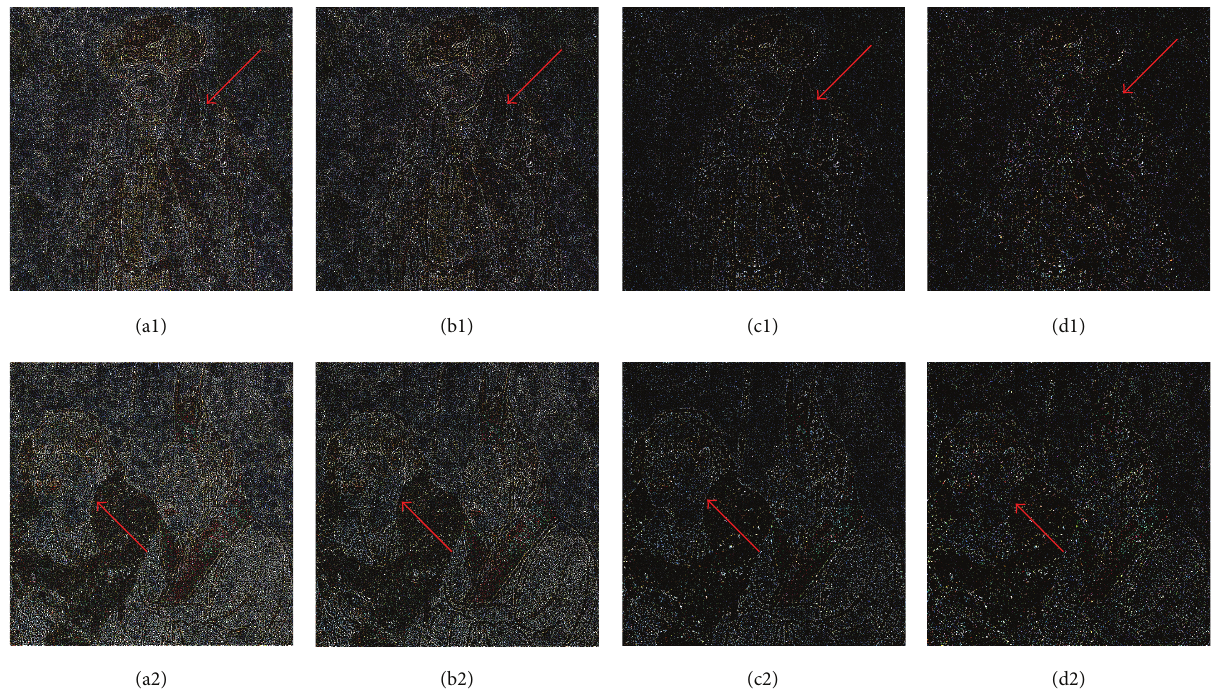
Figure 11: Difference between original and denoised images. (a1), (b1), (c1), and (d1) are lost structures in denoising Figure 1(b) using median filtering, total variation, wavelet, and the proposed method, respectively; (a2), (b2), (c2), and (d2) are lost structures in denoising Figure 1(c) using median filtering, total variation, wavelet, and the proposed method,